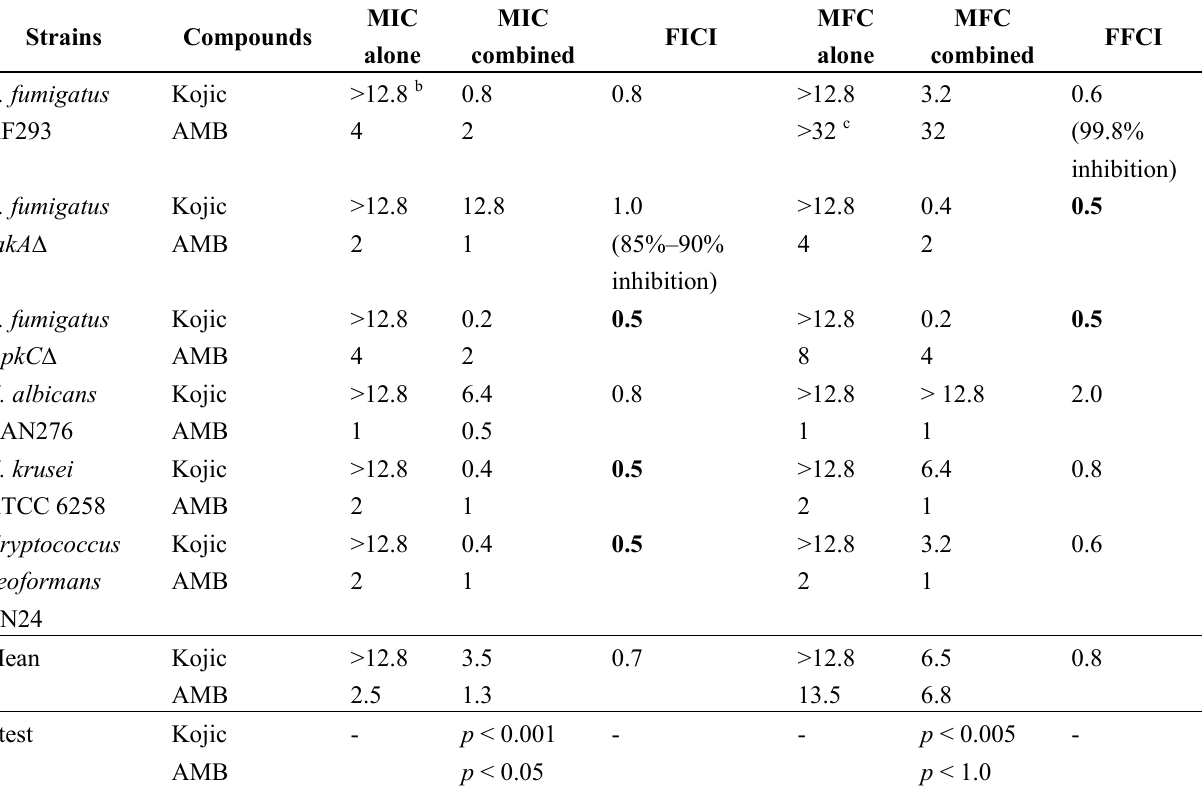
Table 3. Antifungal chemosensitization of kojic acid (mM) with AMB (µg/mL) tested against Aspergillus and yeast strains. a MFCs are concentrations where ≥ 99.9% fungal death was achieved, except where noted in the